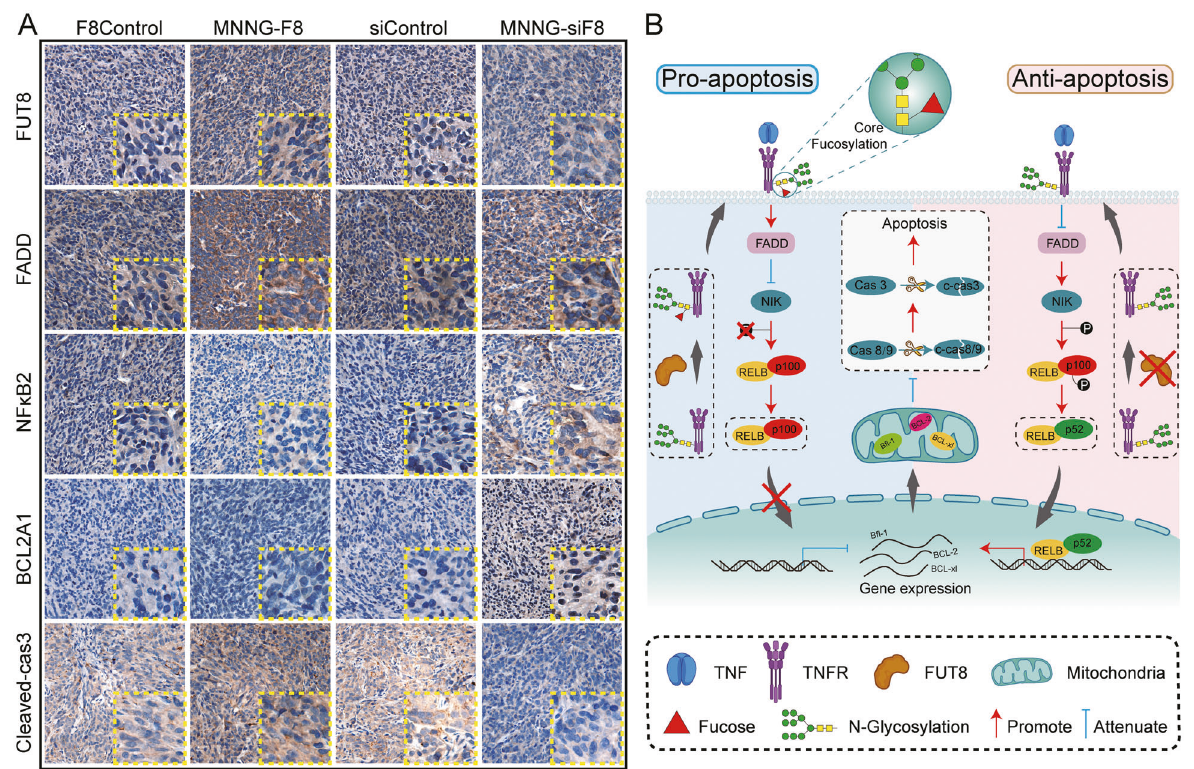
Fig. 8 FUT8 negatively regulates NF- κ B2 signaling by blocking the activation of TNFR. A Immunohistochemical staining of FUT8, FADD, NF κ B2, BCL2A1, and cleaved-caspase 3 in xenografts of OS tissue from the subcutaneous tumor nude mouse model visualized by